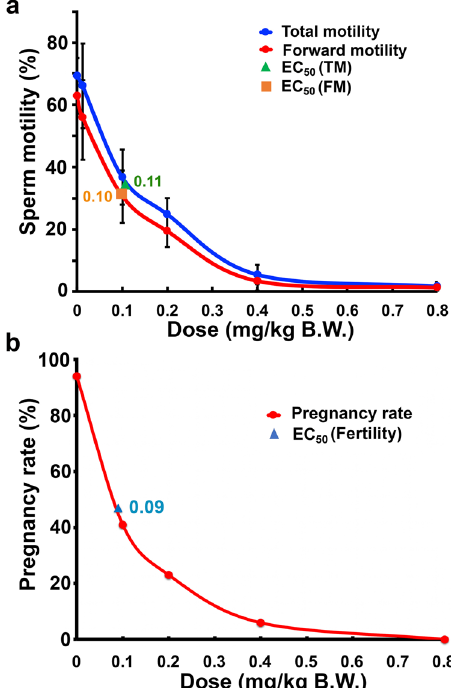
Fig. 4 The EC 50 of triptonide in adult male C57BL/6J mice. a The EC 50 of triptonide in inhibiting sperm total (TM) and forward (FM) motility in adult male mice. Data points represent mean ± SD; n = 5 for doses 0, 0.4, and 0.8 mg/kg BW, and n = 9 for doses 0.1, 0.125, and 0.2 mg/kg BW. b The EC 50 of triptonide in inducing male infertility in adult mice. Data points represent pregnancy rate, which re fl ects percentage of pregnancy among all of the plugged females by the males treated with fi ve doses of triptonide (0, 0.1, 0.2, 0.4, and 0.8 mg/kg BW) for 4 weeks. n = 14 for each of the fi ve doses